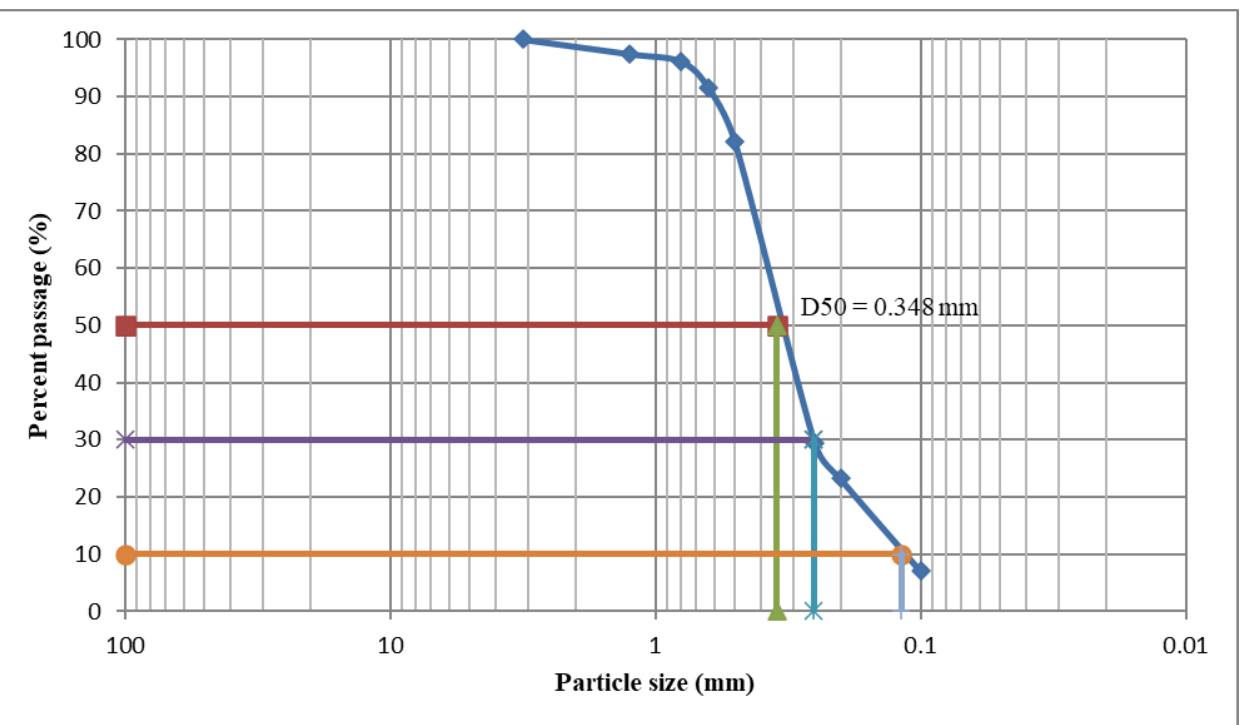
Figure 4. The granulometric distribution that characterizes the porcelain powder morphology.